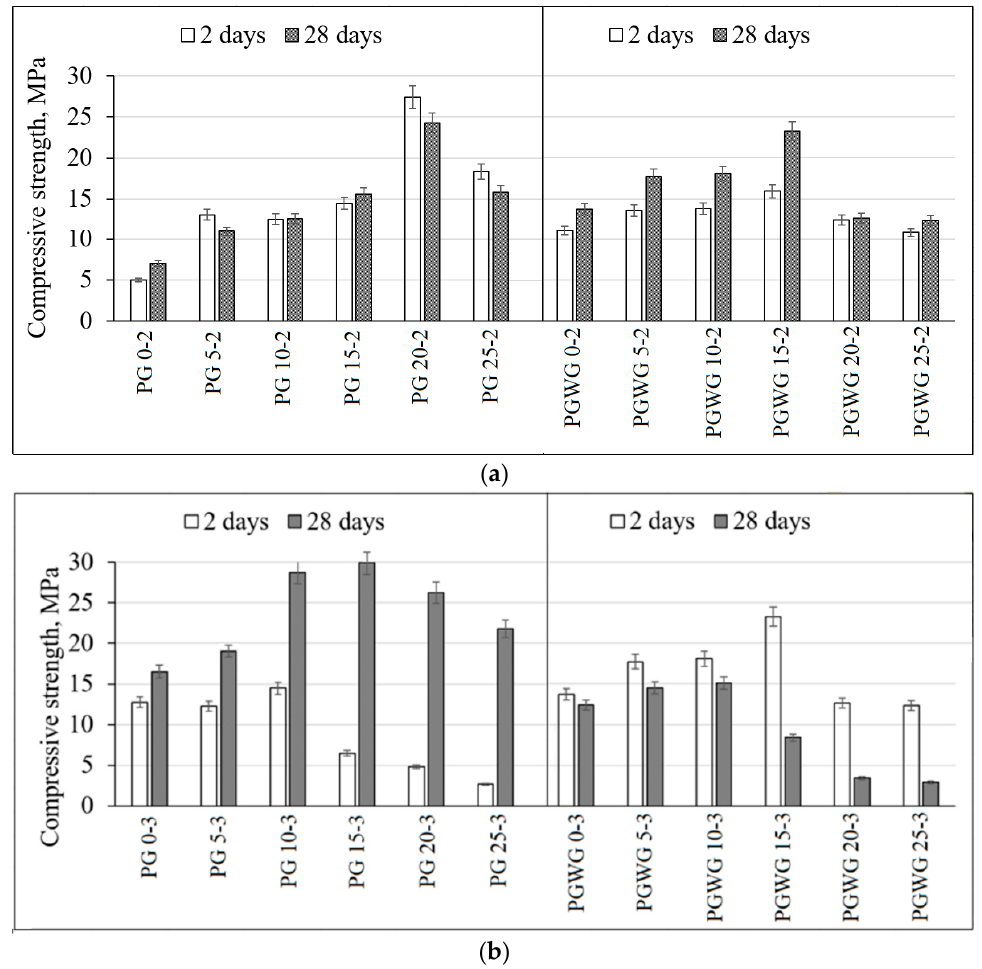
Figure 4. Compressive strength of alkali-activated biomass bottom ash pastes when SiO 2 /Na 2 O molar ratio is (a) 2 and (b) 3 (Table 2).